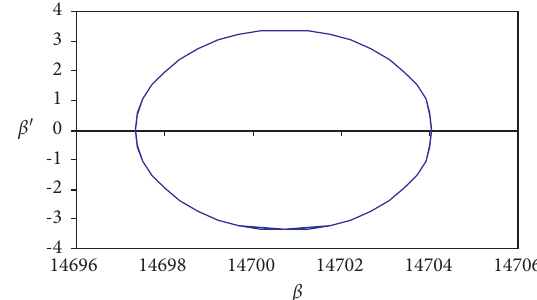
Figure 29: The stability phrase β ′ and β for case (iii) in Section 4.2.